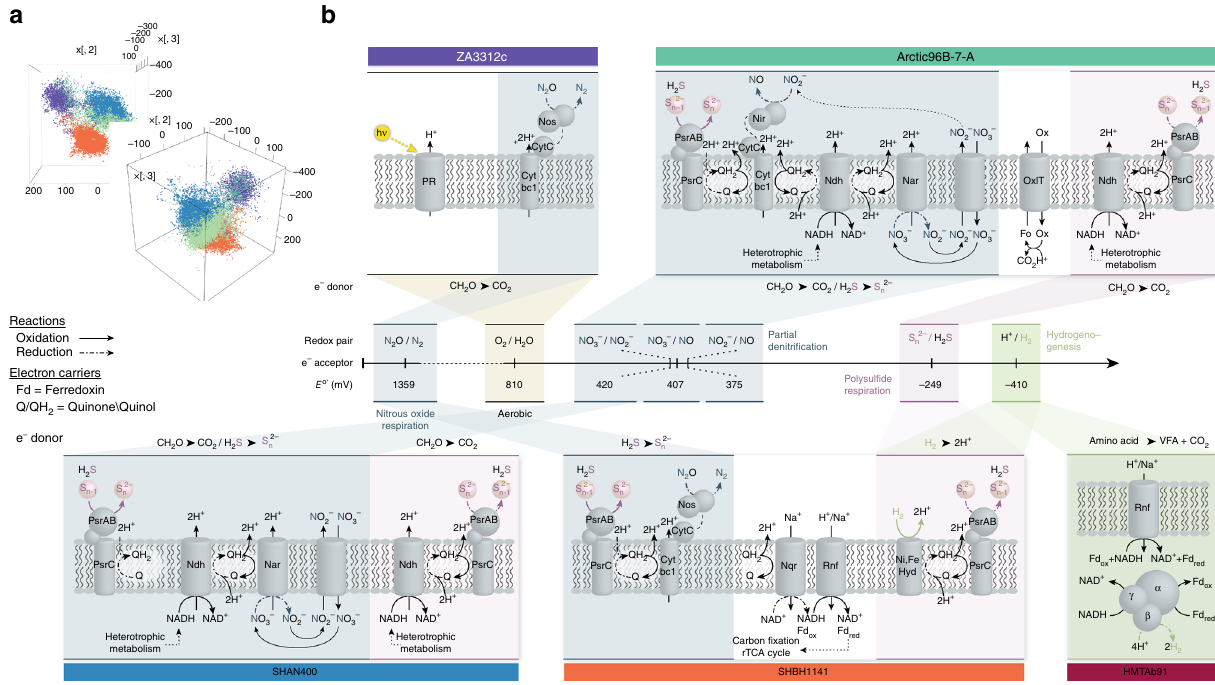
Fig. 3 Energy metabolism of Marinimicrobia population genome bins. a Binning of Marinimicrobia population genomes by Kmer frequency principal component analysis, two rotations of three-dimensional plot, clouds of color coded genome bins are apparent. b Summary of co-metabolic and energy metabolism and conservation strategies of Marinimicrobia population genomes from along eco-thermodynamic gradients, for oxygen (beige), nitrogen (blue), sulfur (pink), and hydrogen (green). Enzymes include: proteorhodopsin (PR), sulfur: polysul fi de reductase (PsrAB, PsrC); nitrogen: nitrite reductase (Nir), nitrate reductase Nar, nitrate/nitrite antiporter (NirK), nitrous oxide reductase (Nos); hydrogen metabolism: Ni,Fe hydrogenase (Ni,Fe Hyd), hydrogenase complex (HydBD); respiratory elements: cytochrome bc1 complex (Cytbc1), NADH dehydrogenase (Ndh), energy-conserving putative electron transfer mechanisms putative ion-translocating ferredoxin:NADH oxidoreductase (IfoAB); oxalate transporter (OxlT); Rhodobacter nitrogen fi xation complex (Rnf). Oxidation and reduction indicated by solid or dotted arrows,